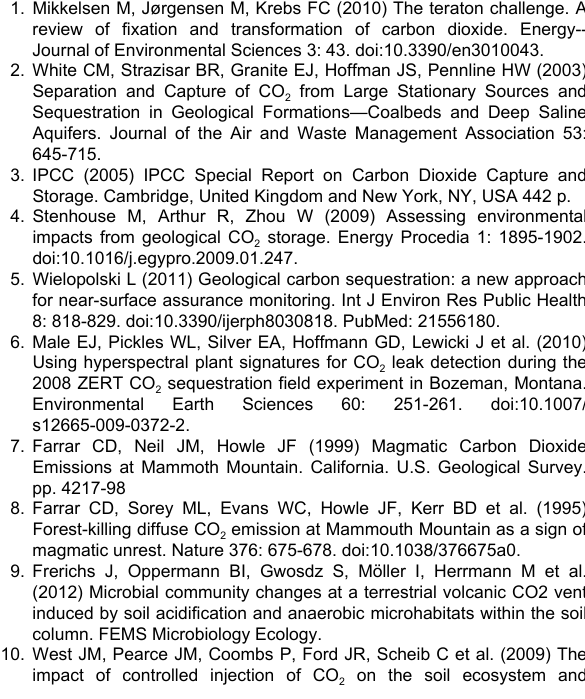
Table S4. Changes in non-parametric Spearman’s ϱ between different variables in response to CO . 2 Figure S1. Principal component analysis for (from right to Table S5. Pairwise correlations for all variables with and left) transcript (mRNA) abundances, gene (DNA) without CO exposure. abundances, transcript and gene abundance combined, 2 and gene and transcript abundances combined with atmospheric data. Panel (A) shows June sample data only. Table S6. Non-parametric Spearman’s correlations for all Panel (B) shows only the July - Sept sample data. A compiled variables with and without CO view for all samples can be seen in Figure 2. Samples are 2 labeled sequentially by treatment (green=background site; red=treatment site active CO injection; orange=treatment site 2 post-CO injection; and yellow=treatment site pre-CO 2 2 injection), and by month (N=June, Y=July-Sept). The percentage of the variation in the samples described by the plotted principle components is indicated on the axis.